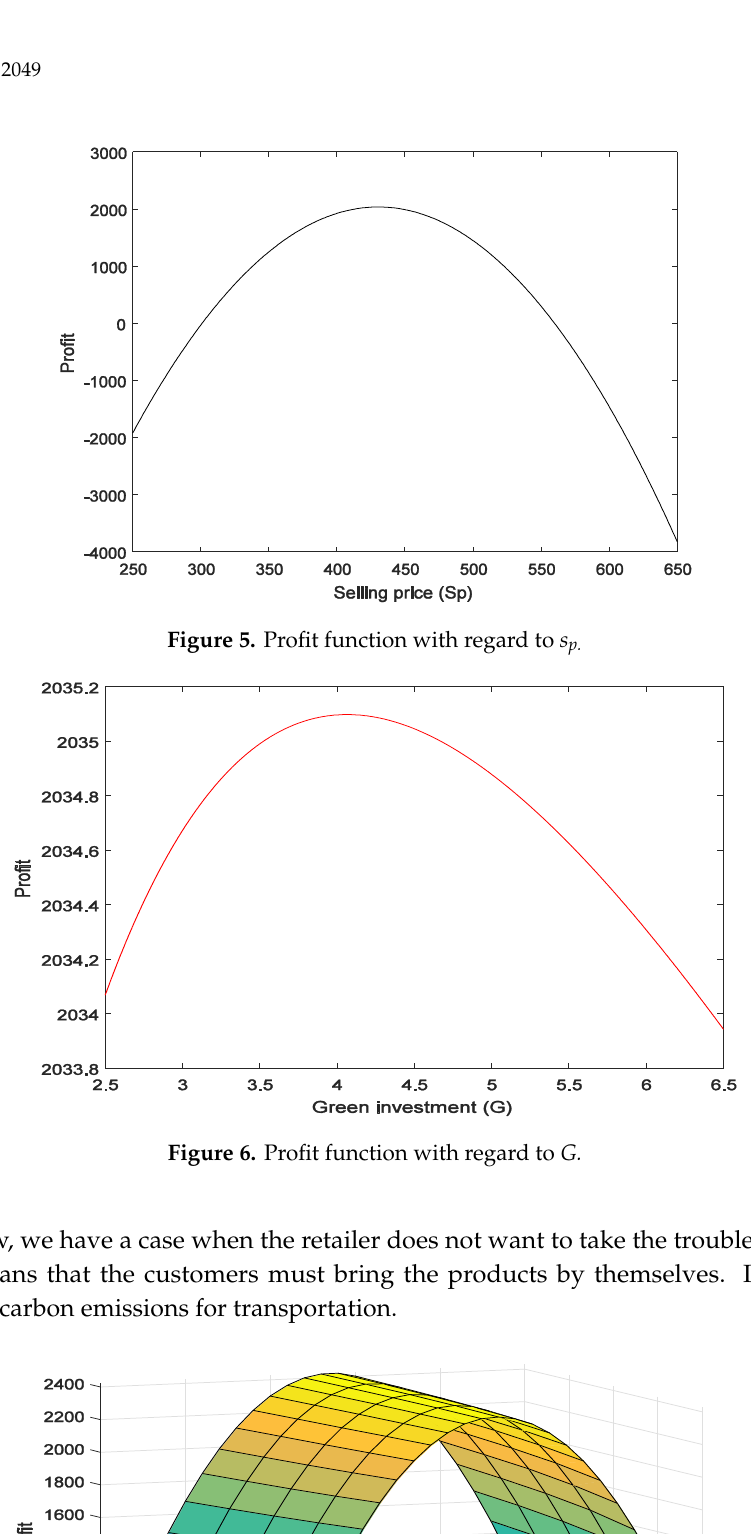
15 of 23 Figure 3. Profit function with regard to G and L.